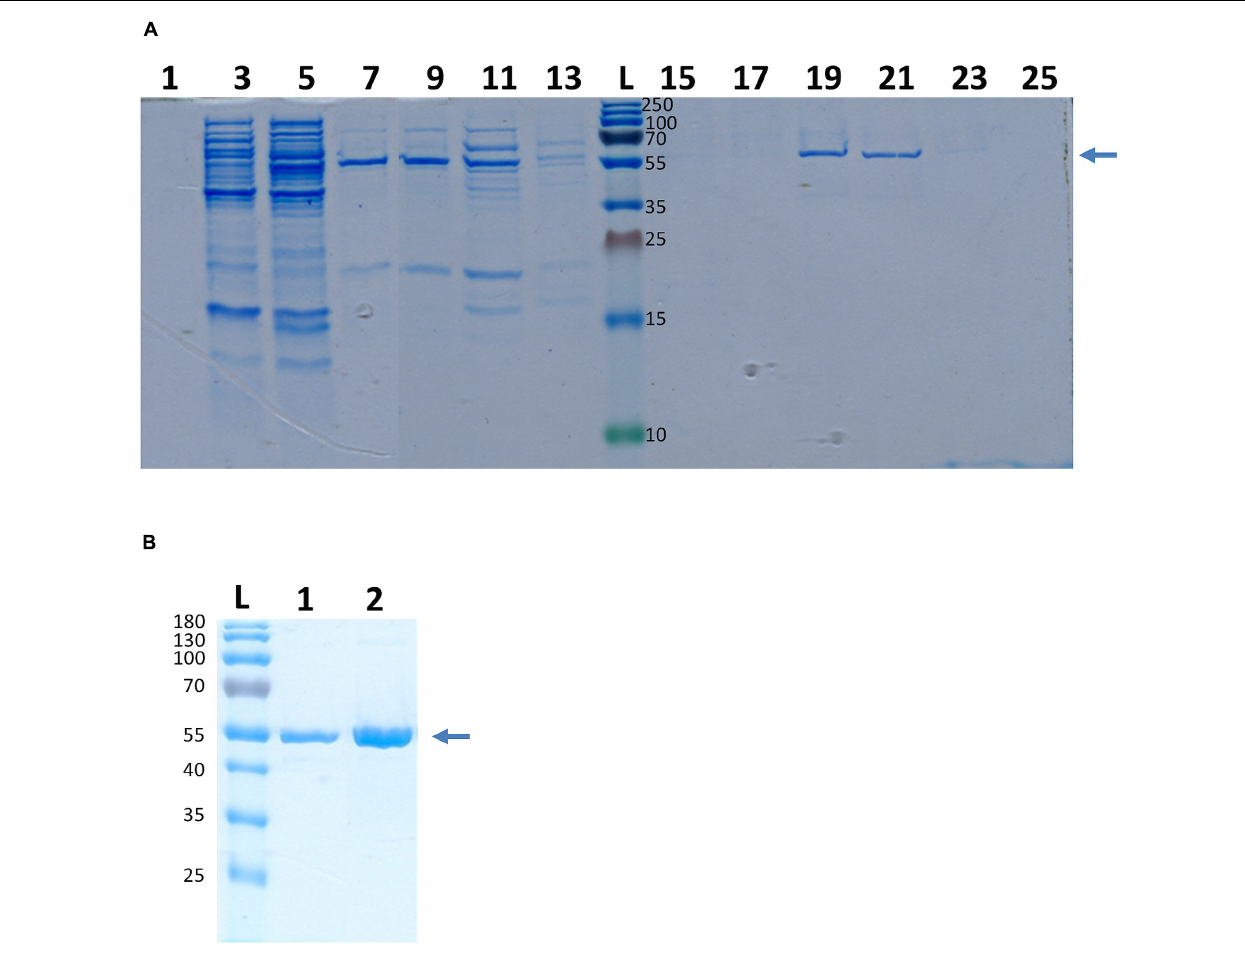
FIGURE 4 | Purification of enolase from S. lugdunensis cell surface fraction and recombinant enolase of S. lugdunensis and humans. (A) Purification of SlEno was realized by ion exchange chromatography. Cell surface fraction was generated by the LiCl treatment and loaded on a high-Q resin column. Increasing concentrations of NaCl (0.25 M/0.5 M/0.75 M) were used for the elution from the column. The fractions (1–25) of the 0.75 M elution step are shown. Gels were stained with Colloidal Coomassie Blue Stain (CCBS). The arrow shows the band corresponding to the enolase. Numbers right of the ladder (L) show kDa of the ladder bands. (B) SlEno was cloned with the pQE30 vector and expressed in Escherichia coli . Afterward the rSlEno were purified via Ni NTA resin, and the elution was separated by SDS page. Recombinant human Eno1 protein (rHEno1) was purchased from a commercial source (Abcam). Gels were stained with CCBS. The arrow shows the band corresponding to the enolases. Numbers on the left show kDa and corresponds to the bands of the ladder (L). 1–rSlEno,